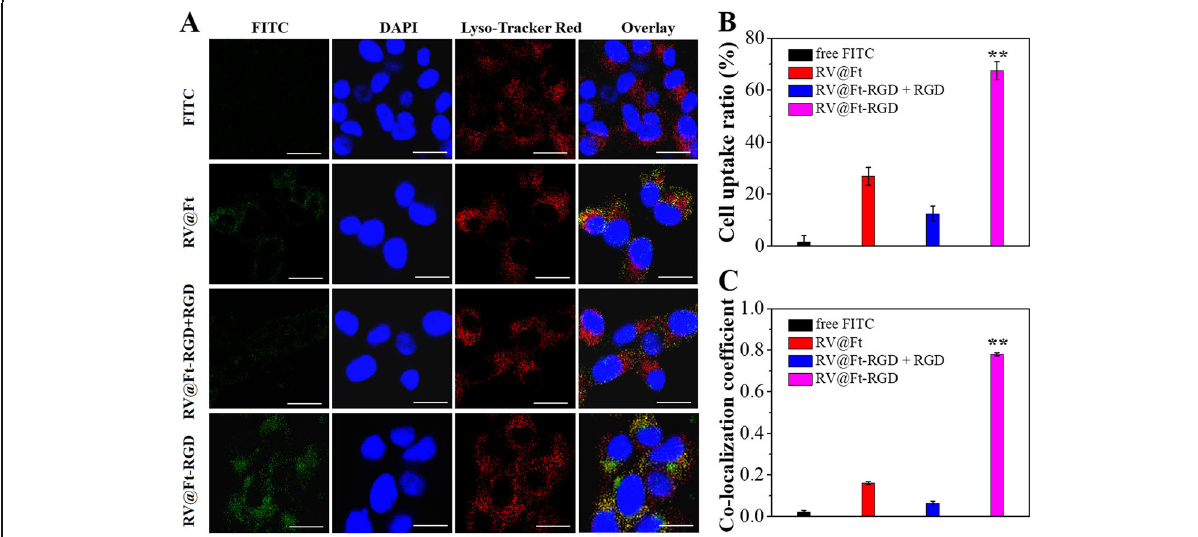
Fig. 4 a Fluorescence images of A549 cells after incubation with free FITC and FITC labeled RV@Ft, RV@Ft-RGD + RGD, and RV@Ft-RGD, respectively. Scale bar = 60 μ m. b FCM measurement of cellular FITC fluorescence intensities in A549 cells after incubation with free FITC and FITC labeled RV@Ft, RV@Ft-RGD + RGD, and RV@Ft-RGD, respectively. c Co-localization coefficient of cellular fluorescence of FITC and Lyso Tracker Red. **P < 0.01, compared with other groups,